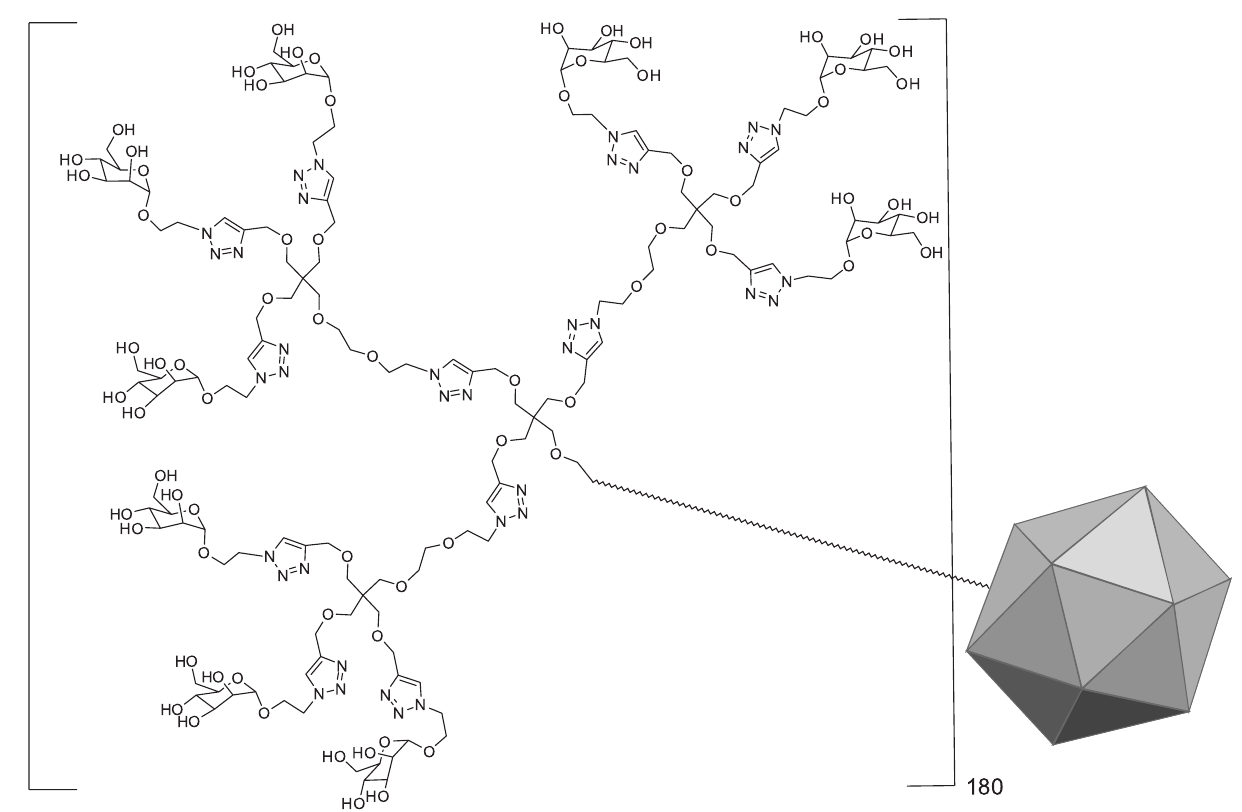
FIGURE 10 - Q b particle bearing 1620 mannose